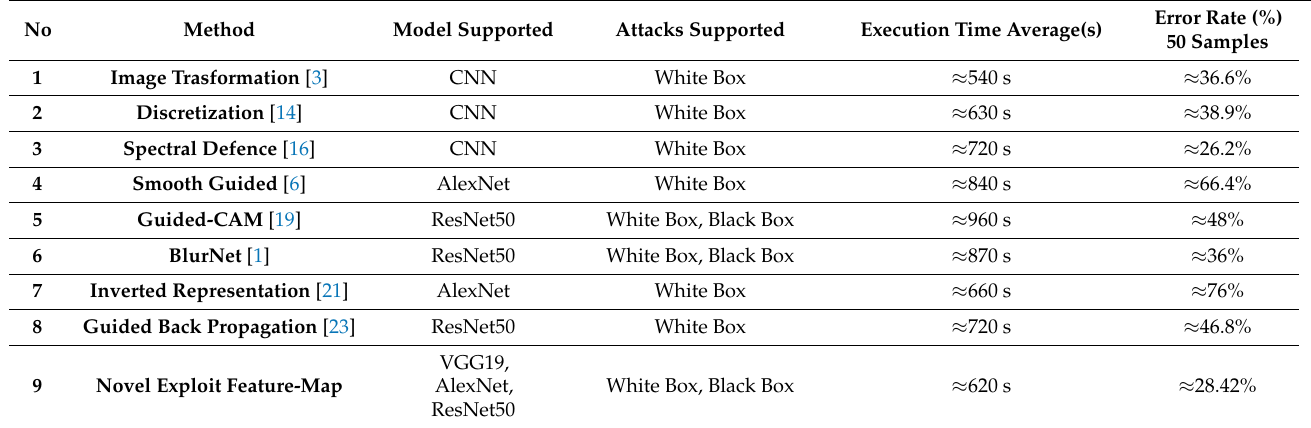
Table 1. Parameter